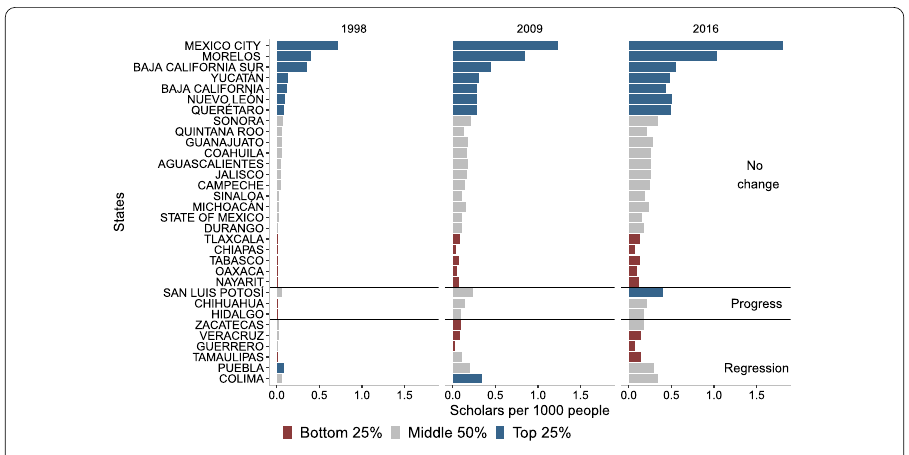
Figure 5 Scholars per capita in Mexico. The horizontal lines separate states that have experienced “No Change”, “Progress” and a “Regression” in their relative position across time. For instance, a state in the “Progress” category may have a density in the bottom 25% in 1998 but a higher density in the middle 50% or higher later on. A state in the “Regression” category experienced a relative fall in its density of scholars: for example, by being in the middle 50 % in 2009 and falling into the bottom 25% in